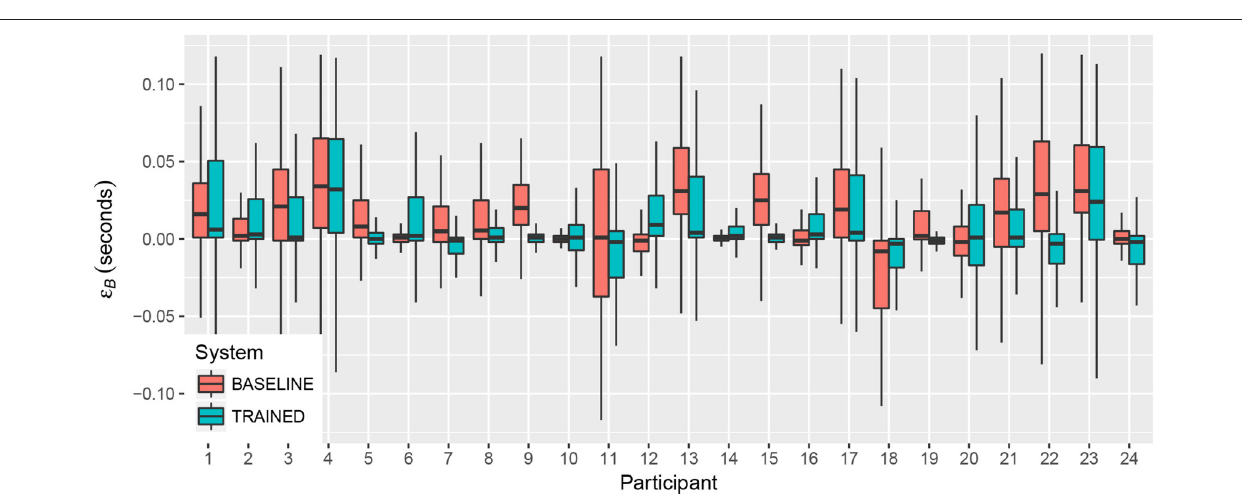
used in the task, F (1,366) = 68.85, p < 0.001. The